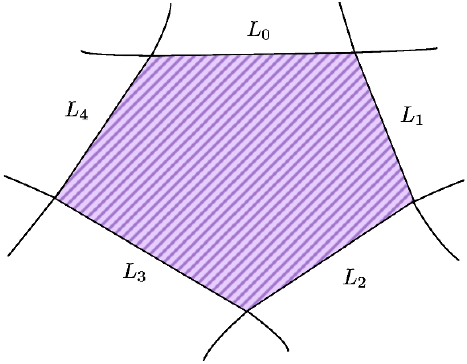
Figure 8. Holomorphic disk bounded by (cid:12)ve